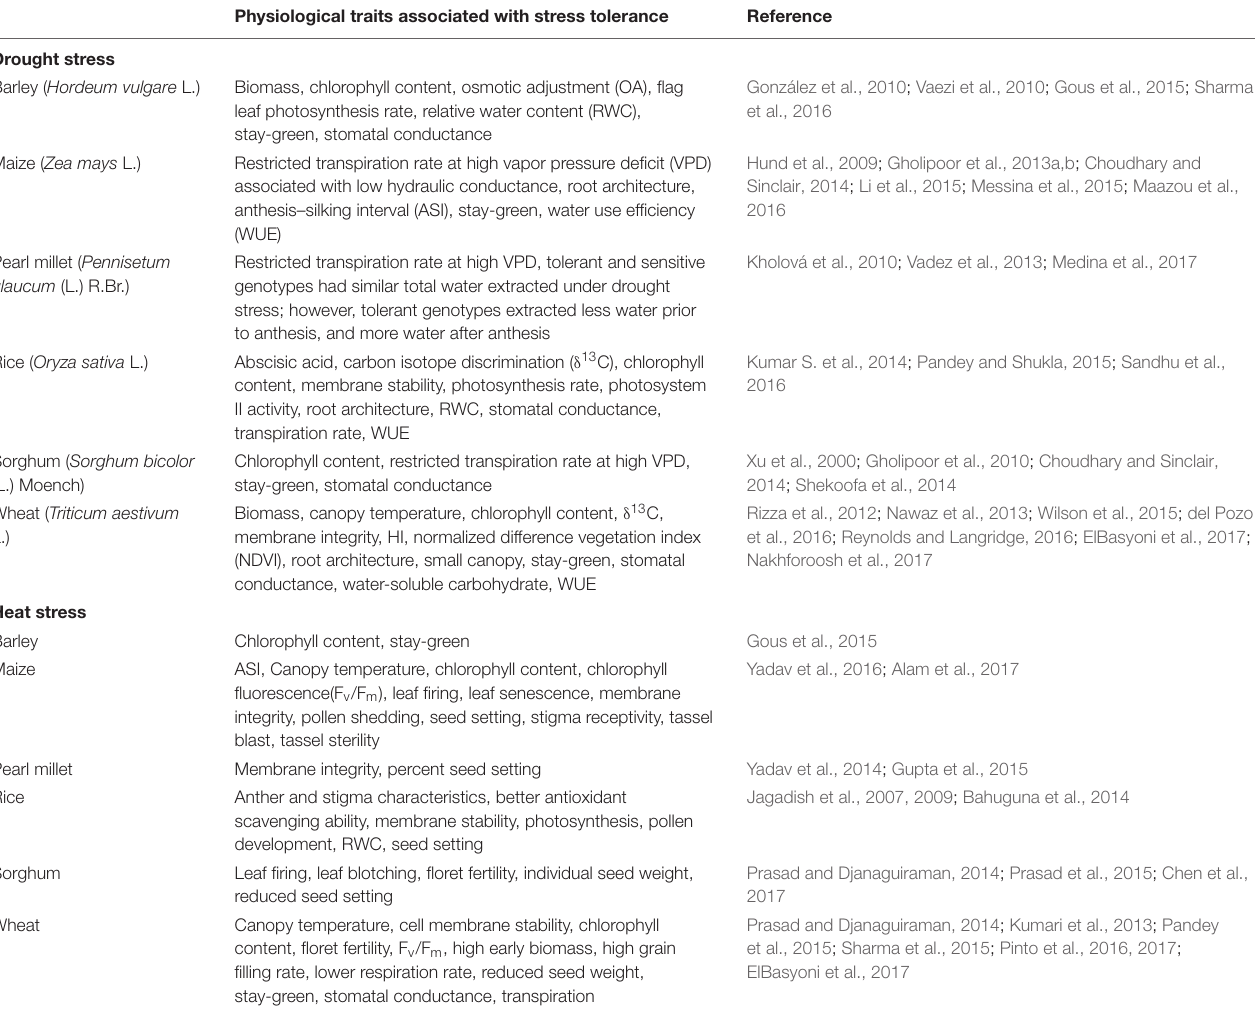
TABLE 2 | Physiological basis of drought and heat stress tolerance in cereals from 2005–2017. Physiological traits associated with stress tolerance